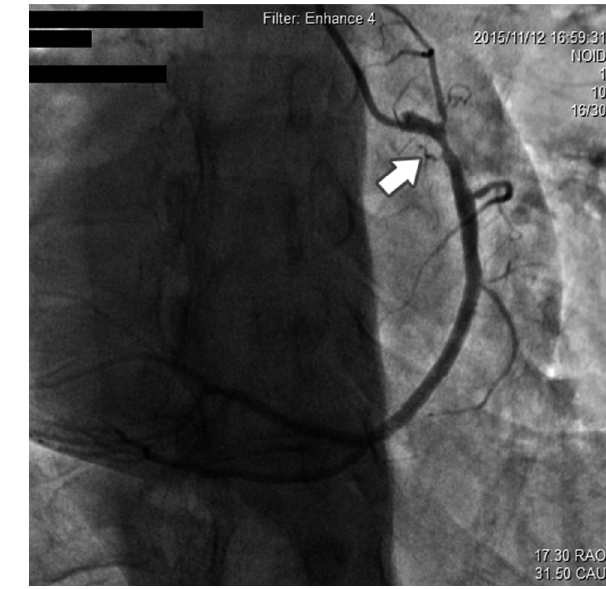
Figure 2: Coronary angiography showing no lesion in LAD. Figure 3: RCA showing nearly 80% of proximal segment